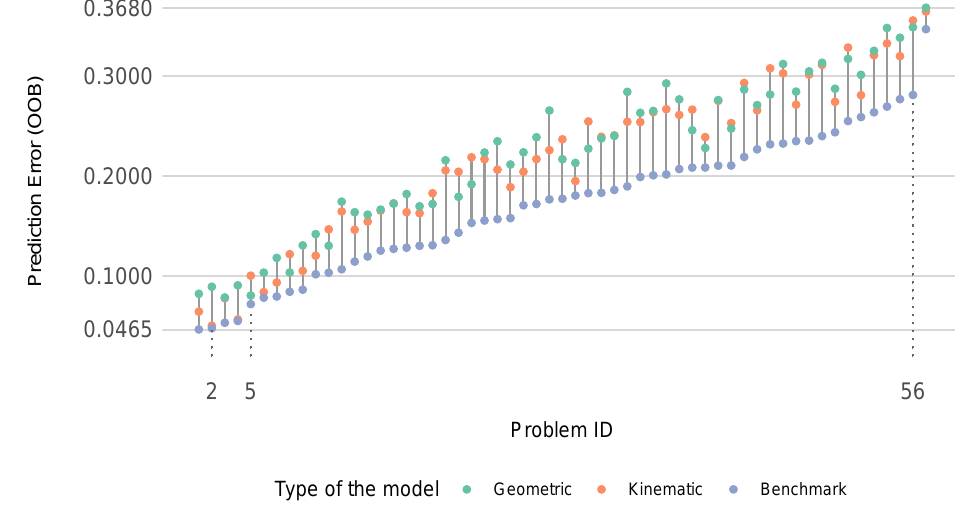
Figure 2. The performance profiles of the random forest models that were based on the 3 different sets of predictors for each of the 57 classification problems. The problems were sorted based on the OOB errors of the models that were based on both geometric and kinematic predictors.